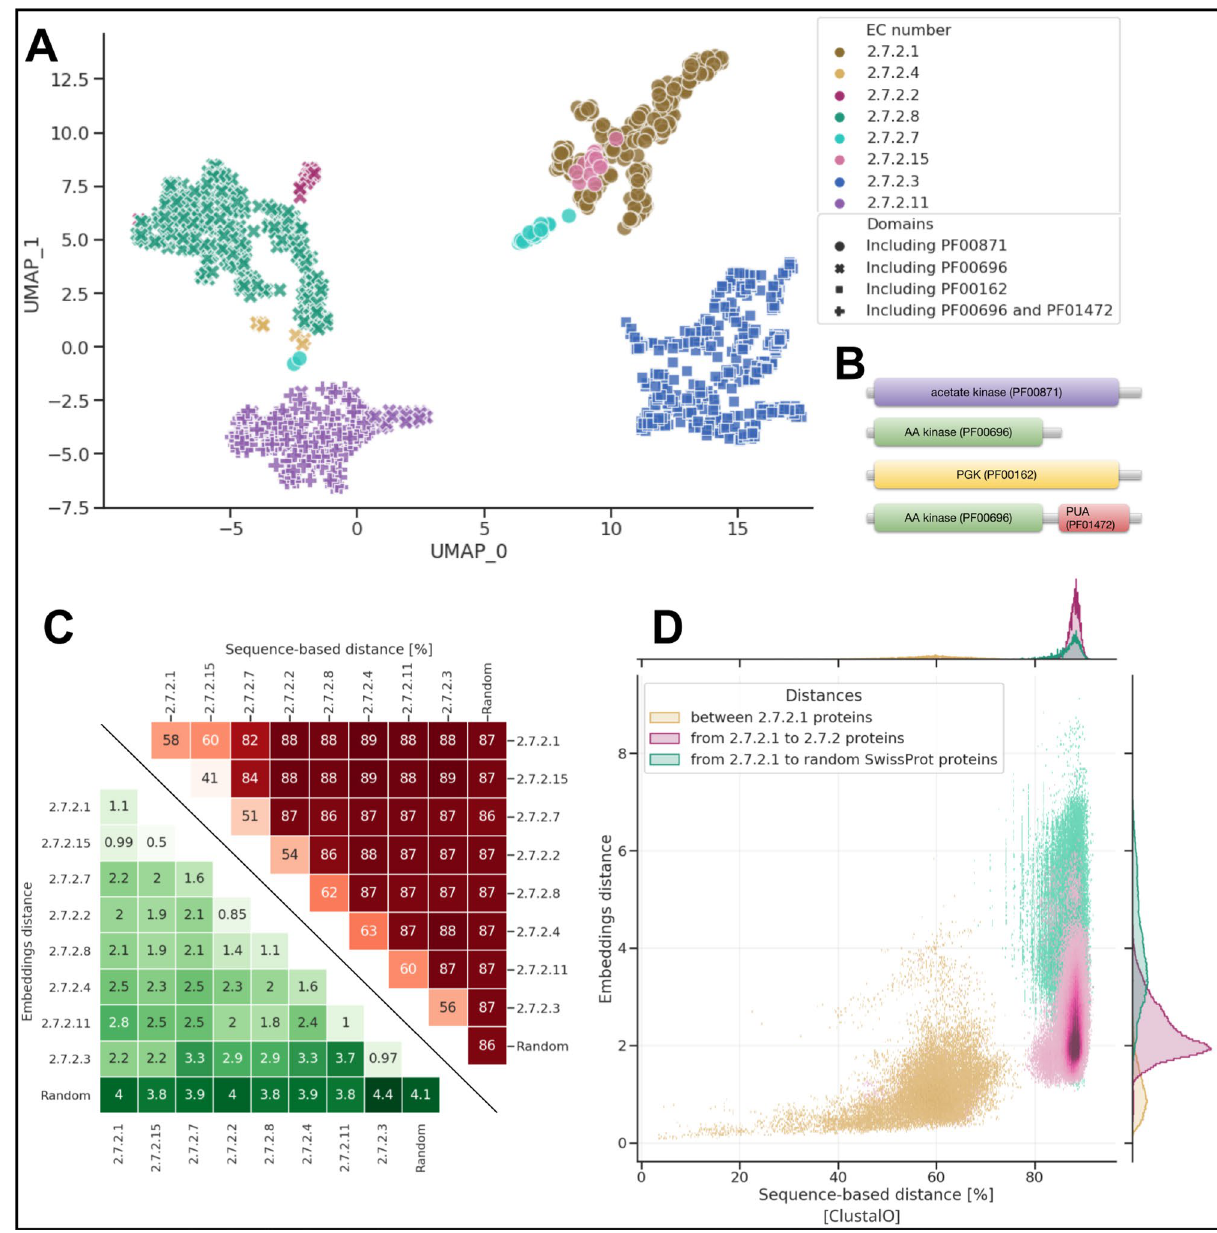
Figure 5. Visualization of EC 2.7.2 proteins in the deep embedding space. ( A ) Deep embeddings of EC 2.7.2 proteins visualized with UMAP. Colors correspond to EC numbers and shapes to PFAM domains. Axes represent UMAP’s first two components. ( B ) Domain architecture of EC 2.7.2. ( C ) The mean distance between EC 2.7.2 proteins and 500 random proteins from the SwissProt space with distinction between embedding- based distance (green) and ClustalO distances (red). Values for both methods were calculated as averages of pairwise distances between all proteins within given clusters. ( D ) Comparison of embedding-based and sequence-based distance (ClustalO) to EC proteins 2.7.2.1. The distances were divided into those within the protein group EC 2.7.2.1, from EC 2.7.2.1 to other EC 2.7.2 proteins, and from EC 2.7.2.1 to randomly selected proteins. The embedding-based, as opposed to the sequence-based distance, differentiates the distances from EC 2.7.2.1 to other members of EC 2.7.2 and from EC 2.7.2.1 to random proteins. Marginal histograms represent data distribution of the two analysed distances in three different categories described